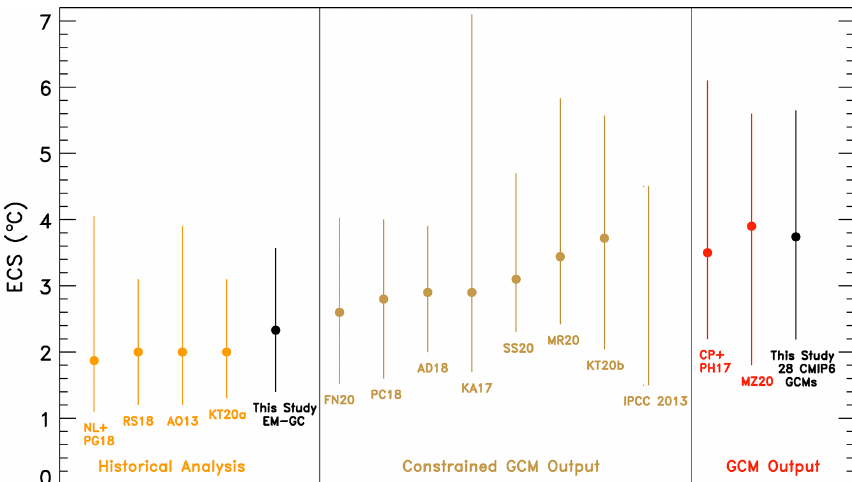
Figure 8. Values of ECS from the EM-GC (black) trained using the HadCRUT5 GMST record, our analysis of the CMIP6 multi-model ensemble (black), and 13 other studies grouped by type of analysis. The studies are listed by lead author (first initial of their first name and first initial of their last name) and the year of publication unless there are only two authors, in which case the initials of both authors are listed. The historical analysis includes Lewis and Grünwald (2018) NL + PG18, Otto et al. (2013) AO13, Skeie et al. (2018) RS18, and Tokarska et al. (2020a) KT20a. Constrained GCM output includes Armour (2017) KA17, Cox et al. (2018) PC18, Dessler et al. (2018) AD18, Nijsse et al. (2020) FN20, Rugenstein et al. (2020) MR20, Sherwood et al. (2020) SS20, Stocker et al. (2013) IPCC 2013, and Tokarska et al. (2020b) KT20b. GCM output includes Proistosescu and Huybers (2017) CP + PH17 and Zelinka et al. (2020) MZ20. The studies estimating effective climate sensitivity are AO13, NL + PG18, RS18, FN20, SS20 KT20a, KT20b, and MZ20. The studies estimating equilibrium climate sensitivity are KA17, AD18, PC18, MR20, and CP + PH17. See the Supplement for the confidence intervals shown for each study and more information about which studies estimate effective or equilibrium climate